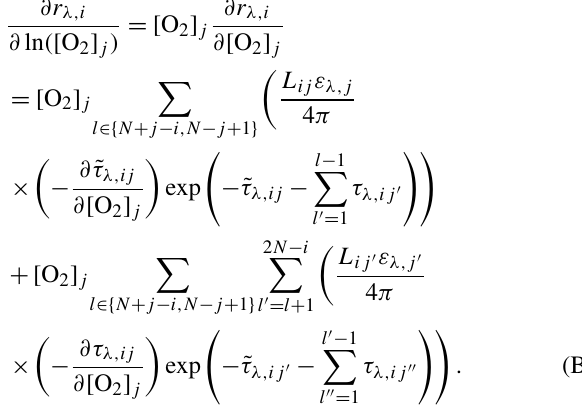
Here the first term on the right-hand side of Eq. (B3) reflects the sensitivity of the effective optical depth of layer j to its own O 2 number density, and the second term reflects the sen- sitivity of its optical depth to its O 2 number density as a trans- mitting layer. Both ∂τ λ /∂ [ O 2 ] ) and ∂ ˜ τ λ /∂ [ O 2 ] can be readily calculated by differentiating Eqs. (16) and